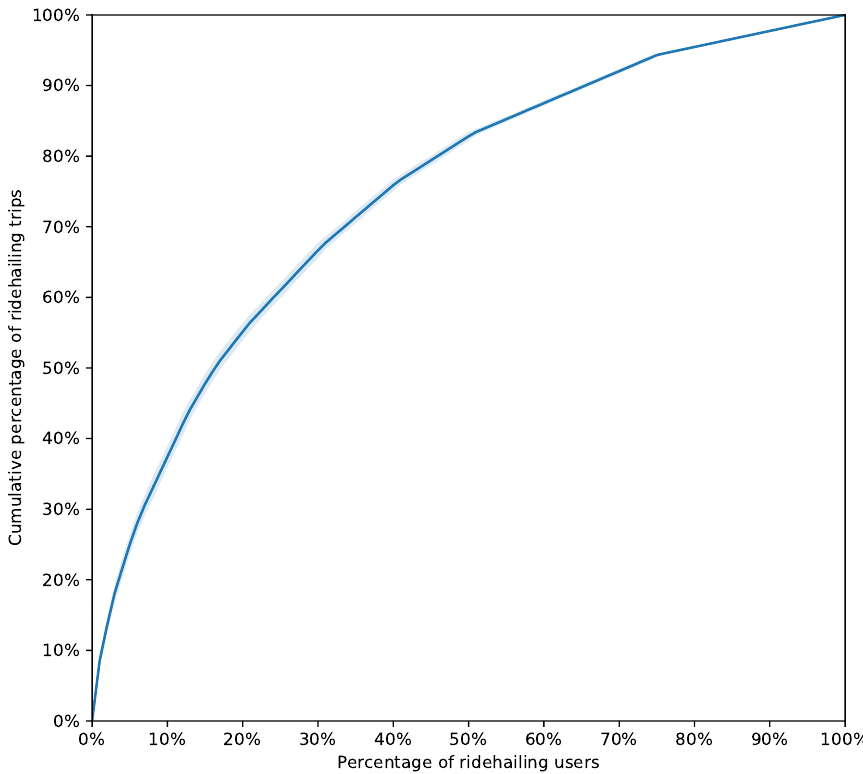
Figure 5. Proportion of ridehailing trips made by ridehailing users (shaded area represents 95% confidence